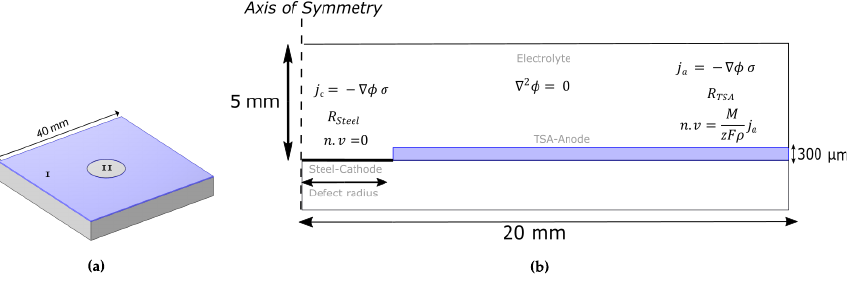
Figure 1. ( a ) Schematic of the thermally sprayed coated sample used in the experiments. I -TSA coating. II -Exposed Steel 5%. ( b ) Boundary